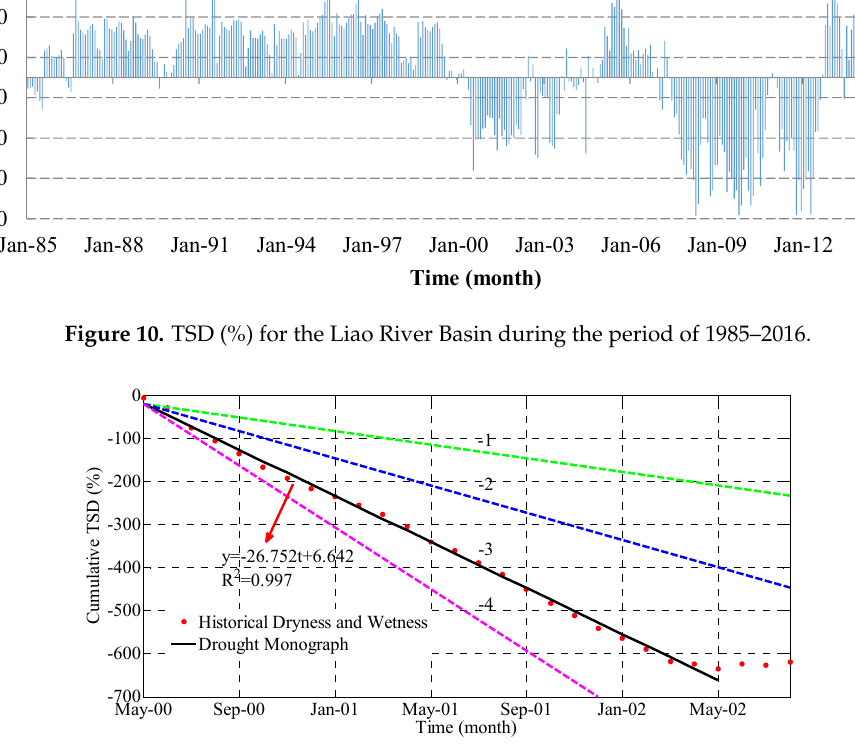
Figure 11. Cumulative TSD of the Liao River Basin in China.